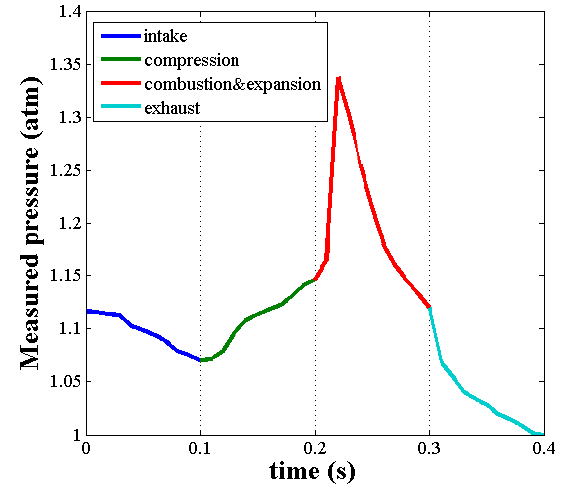
Figure 30. Experimental pressures vs. time for hot state over one cycle.